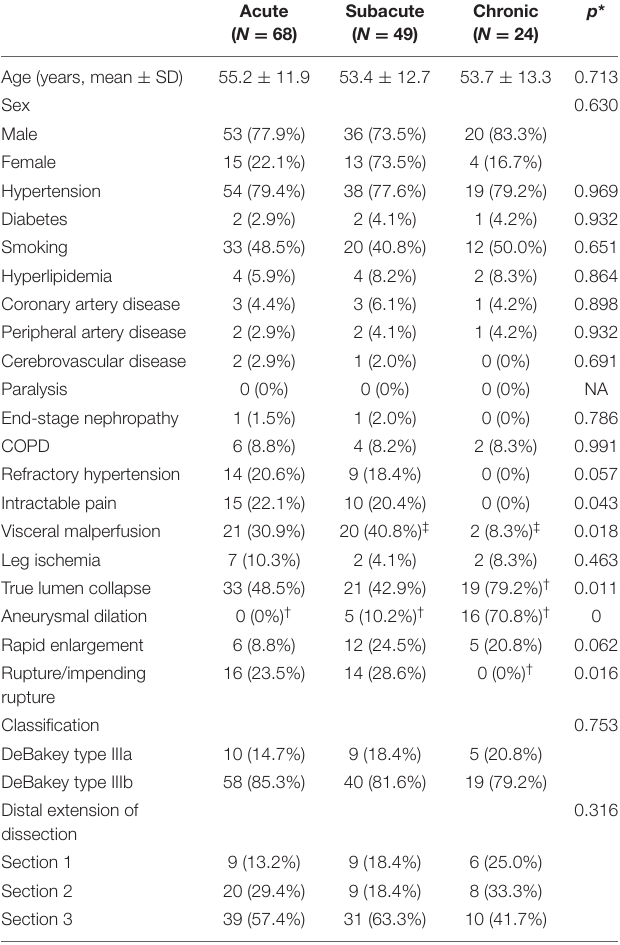
TABLE 1 | Demographic and preprocedural imaging characteristics of patients with type B aortic dissection (TBAD) receiving an endovascular repair.